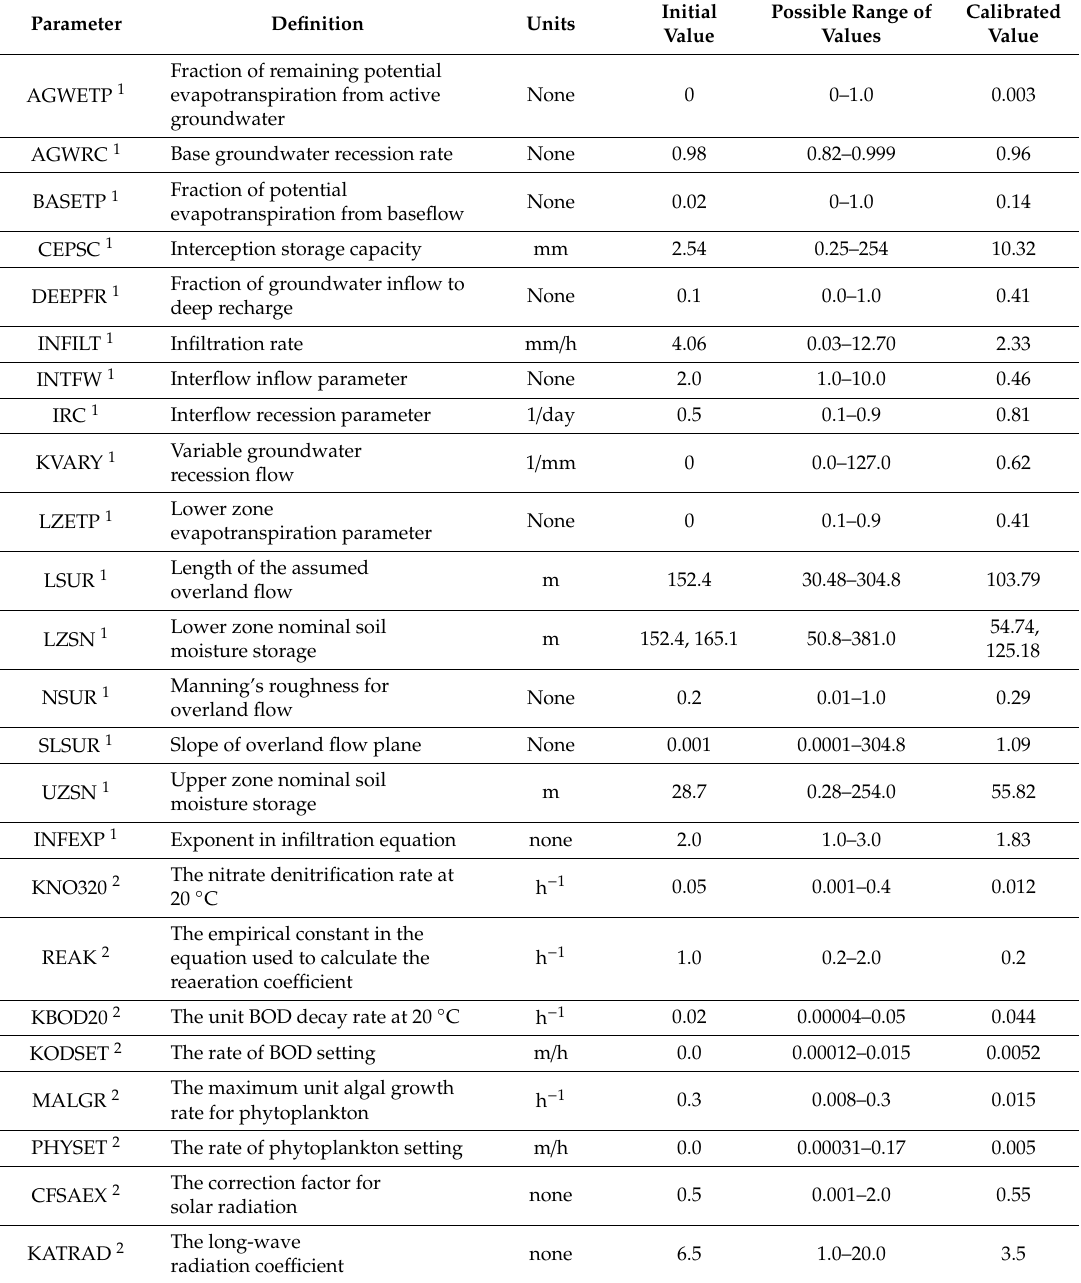
Table 1. Streamflow and water quality parameters used for model calibration at the